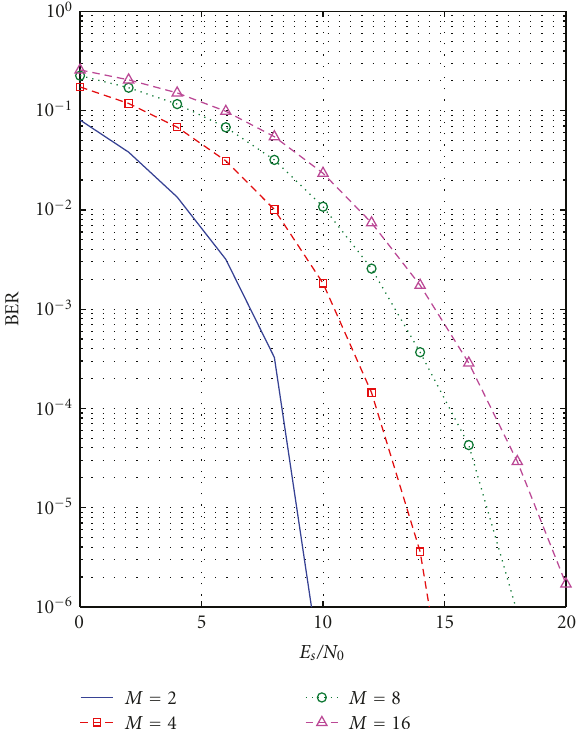
Figure 11: Simulative BER performance of the new modulation scheme for di ff erent modulation orders with a shift step of 0.05 T sig .